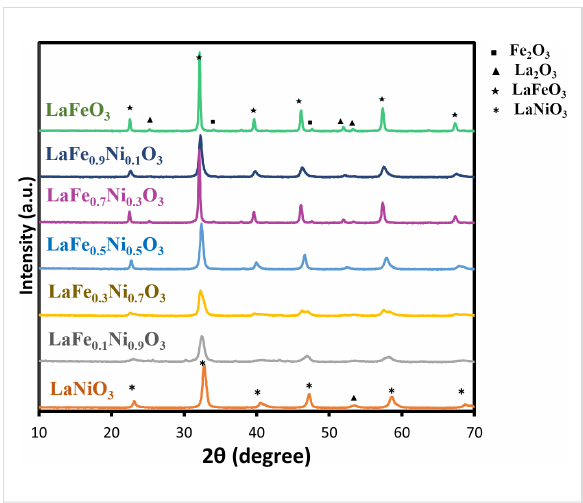
Figure 3: The characteristic XRD patterns of LaFe x Ni 1 − x O 3 .